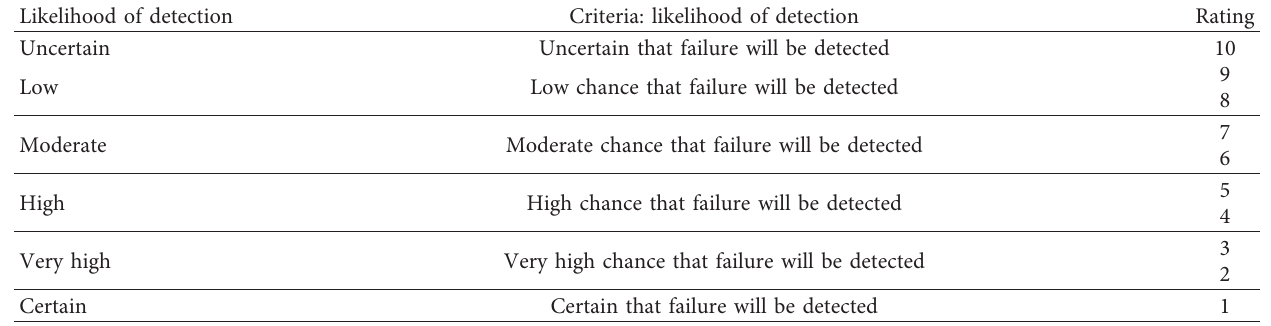
Table 3: Likelihood of detection of failures.